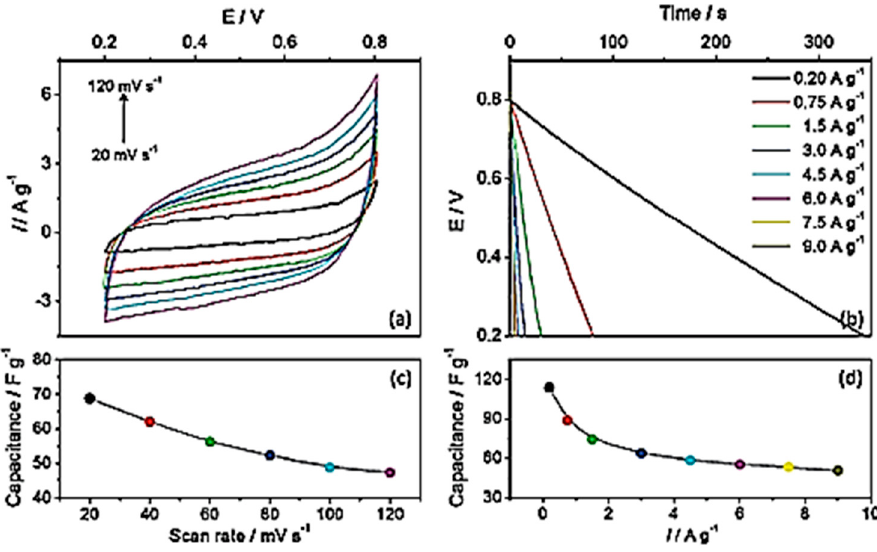
Figure 4. ( a ) Cyclic voltammetric curves at multiple scans, ( b ) discharge curves, and specific capacitance, ( c ) scan rates, ( d ) specific current [36].